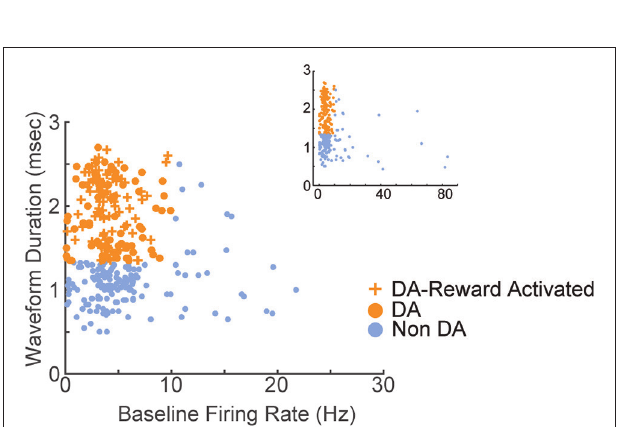
FIGURE 1 | Animals learn to perform serial actions. (A) Actions (nose pokes into a lit port) were reinforced probabilistically with sucrose pellets (rewards). In session 1, each action was reinforced (fixed ratio 1, FR01). In session 2, reinforcement probability decreased to 0.2 in 3 trial blocks (transition, TRANS). In sessions 3–4, the probability of reinforcement was 0.2 (random ratio 5, RR05). In sessions 5–7, the probability of reinforcement was 0.1 (random ratio 10, RR10). At trial start, a cue light was illuminated until the outcome was earned (blue arrow). When an action was reinforced, the cue light was extinguished immediately and the outcome was delivered 0.5s later. (B) Random reinforcement led to different numbers of serial actions performed per trial. (C) Mean ± SEM number of actions required per trial. Shaded area depicts RR10 sessions. Serial action data were drawn from these sessions because these sessions required the greatest average number of actions per trial, and thus, had the greatest statistical power. (D) Mean ± SEM action rate in each session. (E) Mean ± SEM inter-action intervals in low, medium and high bins (actions 1–7, 8–14, and 15–21) during RR10 sessions.